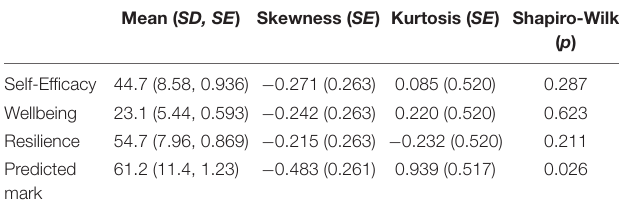
TABLE 1 | Descriptive statistics and normality tests.